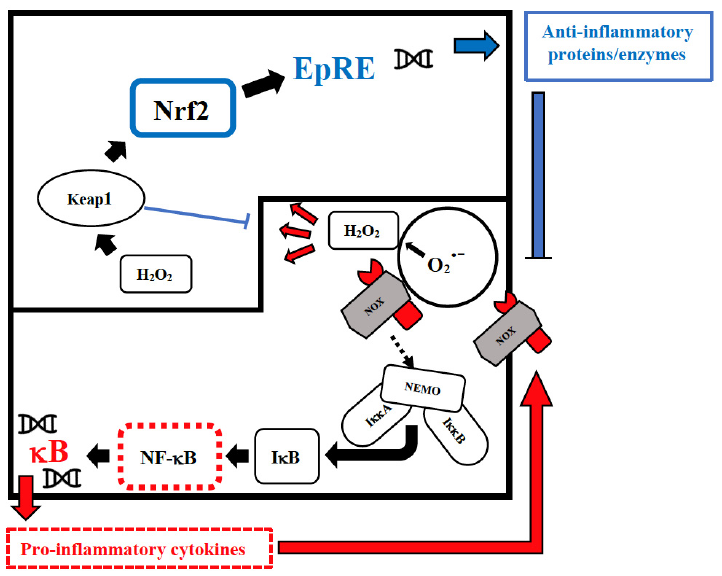
Figure 1. Intranuclear signal transductions can occur in two different pathways: while nuclear factor kappaB (NF- κ B) tends to enhance and perpetuate the inflammatory response by triggering the expression of pro-inflammatory cytokines, nuclear factor erythroid 2–related factor 2 (Nrf2) activation through Kelch-like ECH-associated protein-1 (Keap1) oxidation dampens pro-inflammatory signaling by expression of peroxidases and other anti-inflammatory proteins. As E3-ligase, Keap1 also primes inhibitor of NF- κ B kinase subunit beta (IKK β ) to degradation via ubiquitination, thereby directly interfering with NF- κ B activation. For the sake of clarity, only the reactive oxygen species (ROS)-producing enzyme NADPH oxidase (NOX)-derived H2O2 is shown as an oxidant signal. Depending on the cellular system and the inflammatory stimulus, NOX-derived H 2 O 2 may be supported or replaced by mitochondrial H 2 O 2 , lipoxygenase products, and S-alkylating electrophiles derived therefrom. NEMO, NF- κ B essential modulator; I κ B, Inhibitor of NF- κ